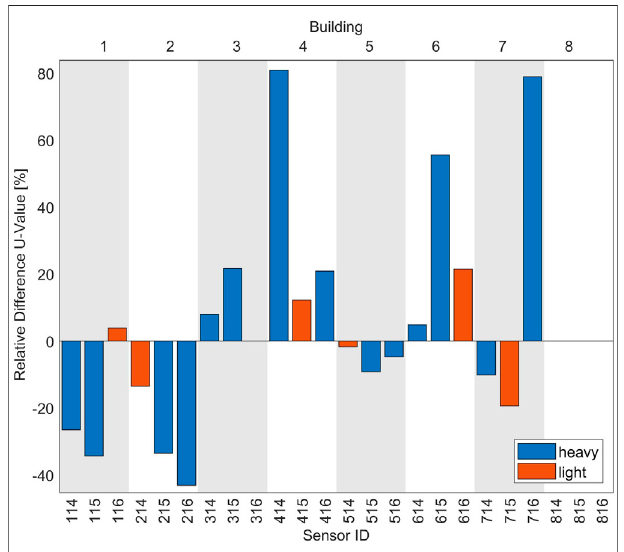
FIGURE 7 | Relative differences between U-values derived from calculations and from measurements.